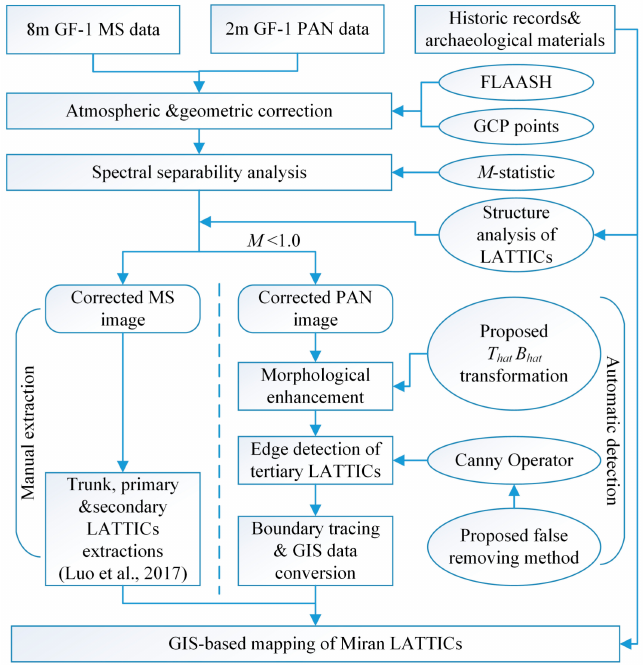
Figure 4. Flowchart for automatic extraction and mapping of Miran